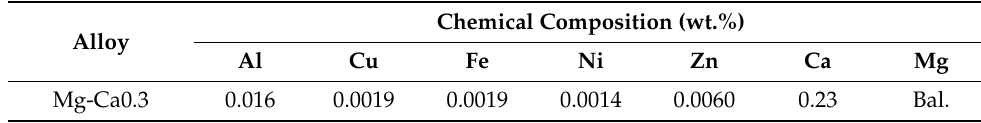
Table 1. Nominal composition of the extruded Mg-Ca0.3